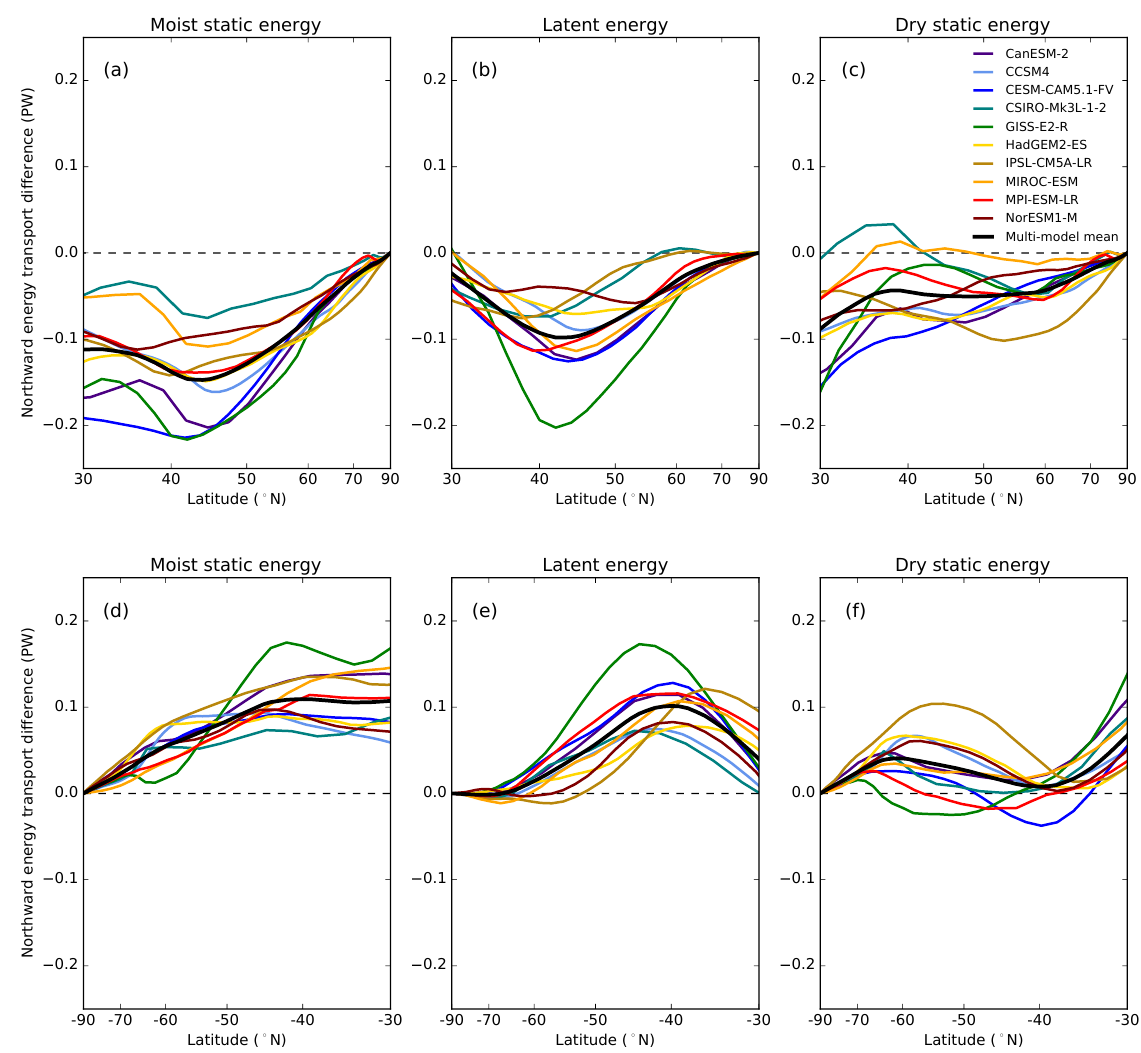
Figure 1. Northward energy transport (PW) for G1 – piControl, poleward of 30 ◦ N (a–c) and 30 ◦ S (d–f) , for total moist static energy transport (a, d) , latent energy transport (b, e) , and dry static energy transport (c, f) , in the GeoMIP models and the multi-model